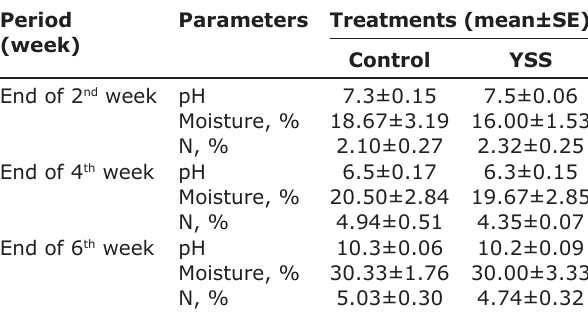
Table-4: Litter quality assessment parameters of various treatment. Period (week)